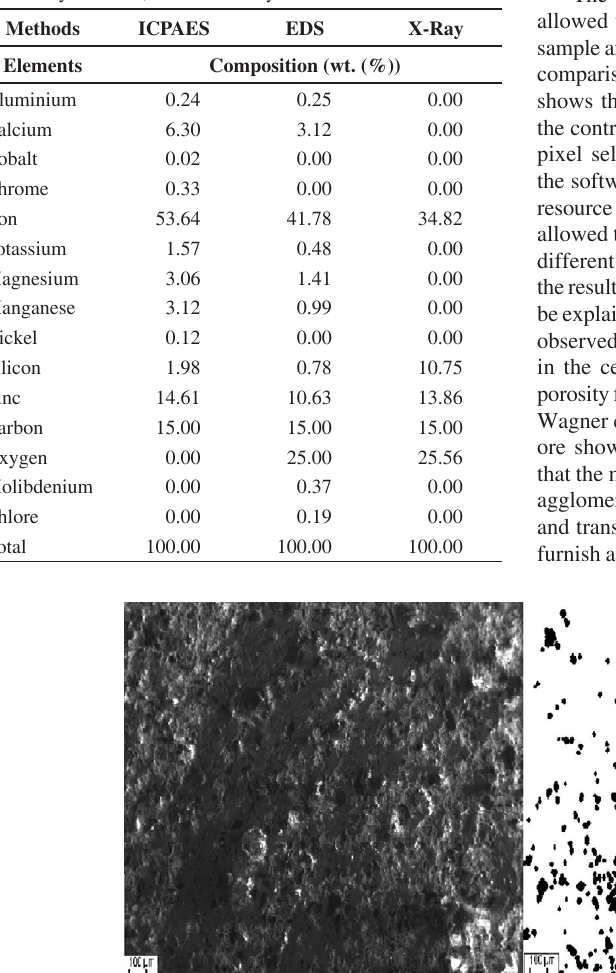
Table 1. Average elements in the sample of EAF dust pellets detected by ICPAES, EDS and X-ray diffraction.